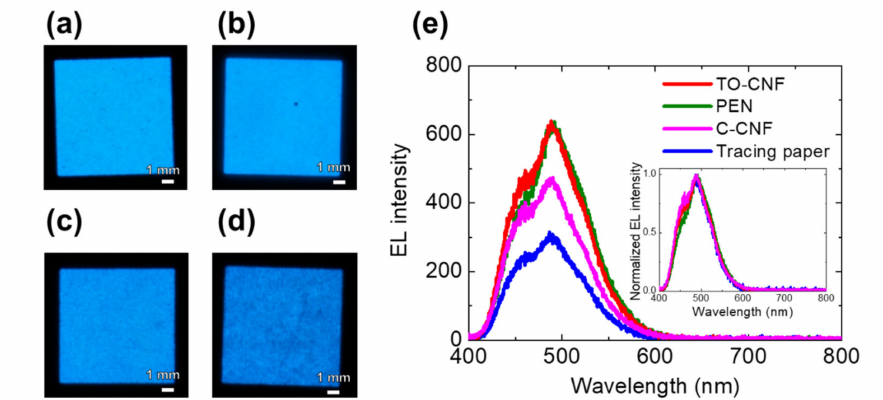
Figure 3. Photographs of the powder EL devices with a substrate of ( a ) TO-CNF, ( b ) PEN, ( c ) C-CNF, and ( d ) tracing paper under the application of an AC voltage of ± 170 V at 1.2 kHz. ( e ) Electroluminescent (EL) spectra of the devices with each substrate under the application of an AC voltage of ± 170 V at 1.2 kHz. The inset shows the normalized EL spectra of the devices.